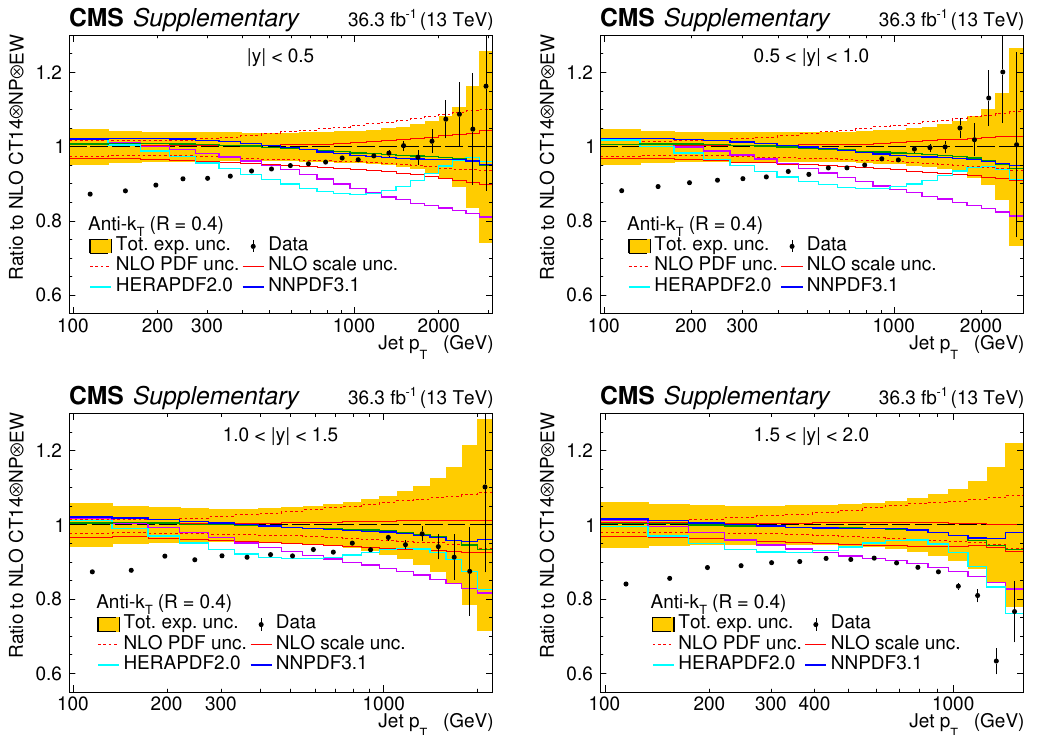
Figure 21 . Cross sections of inclusive jet production for distance parameter R = 0 . 4 as a func- tion of transverse momentum of the individual jet in bins of absolute rapidity | y | , compared to the theoretical predictions at NLO using different PDFs (lines of different colors). All results are normalised to the prediction at NLO obtained using CT14nlo PDF (black dashed line). The mea- surement (solid symbols) is presented with the statistical uncertainties (vertical error bars), while the systematic uncertainty is represented by a yellow filled band, centered at